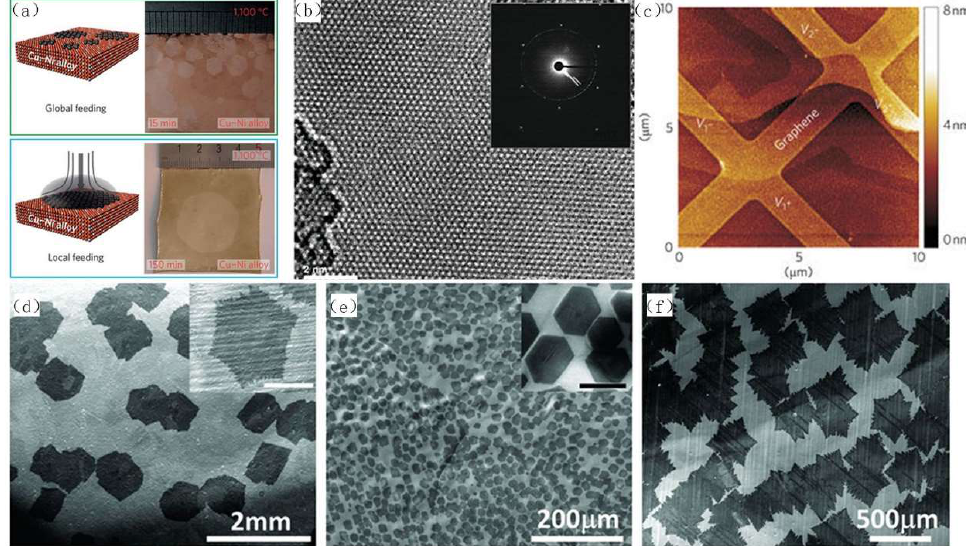
Figure 2. Synthesis of graphene. ( a ) Global and local growth of graphene on Cu–Ni substrate [41]; ( b ) Monolayer graphene synthesized on H-terminated Ge(110) surface by low pressure chemical vapor deposition (CVD) method at 900 to 930 °C [42]; ( c ) Atomic force microscope (AFM) image of graphene synthesized based on SiC substrate [43]; ( d – f ) The influence of oxygen atoms on the CVD growth